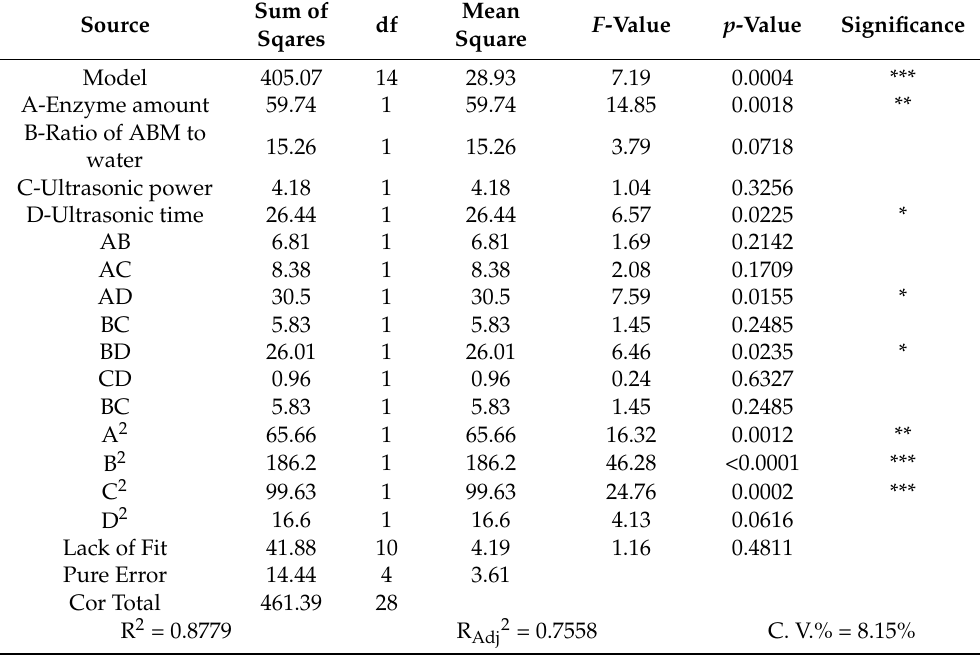
Table 2. Analysis of the variance (ANOVA) for regression